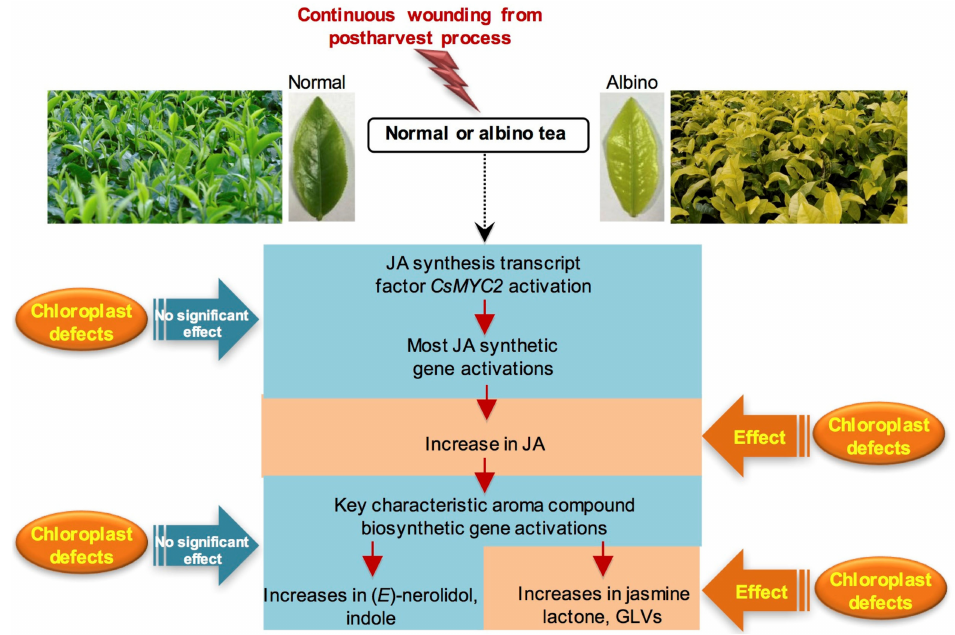
Figure 6. Formations of jasmonic acid (JA) and characteristic aroma compounds in normal tea leaves and albino tea leaves exposed to continuous wounding stress. GLVs, green leaf